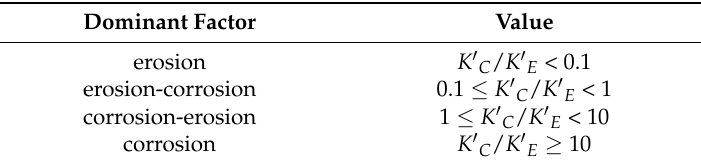
Table 5. Four divided regimes of erosion–corrosion.